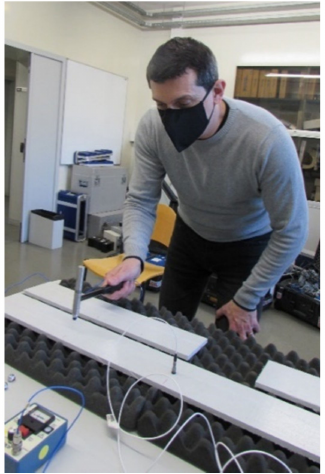
Figure 8. Experimental tests: Example of impact being applied.